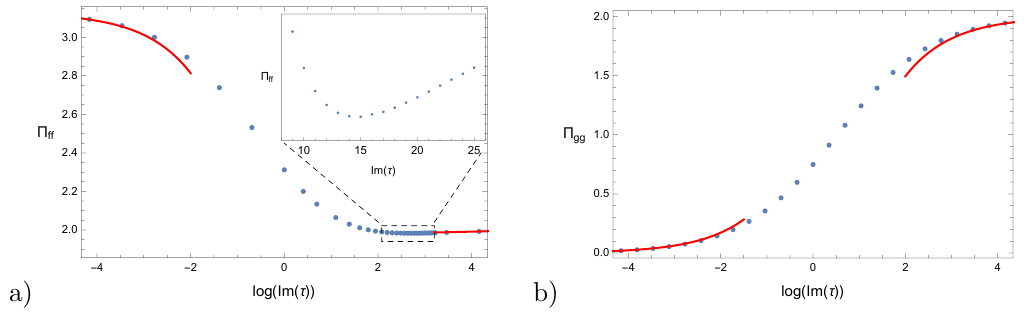
Figure 5 . A plot of (cid:5) vs. Im (cid:28) for the n + = n (cid:0) = 1 theory. We set Re (cid:28) = 0. The solid red curves are saddle point approximations, while the points are determined from numerical integration.